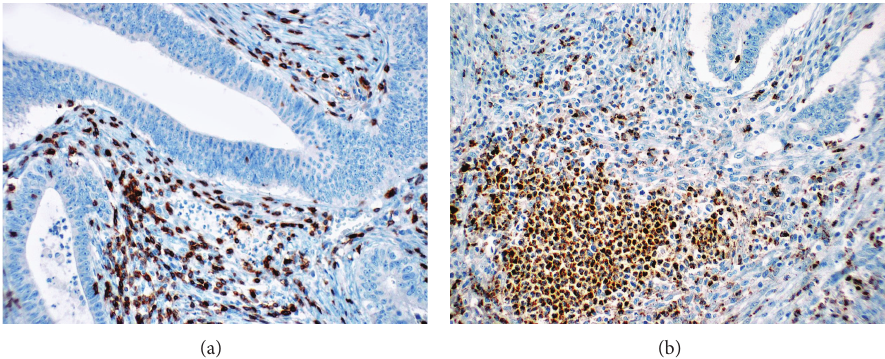
Figure 2: S100A9 staining in intratumoral (a) and peritumoral (b) inflammatory cells ( ×